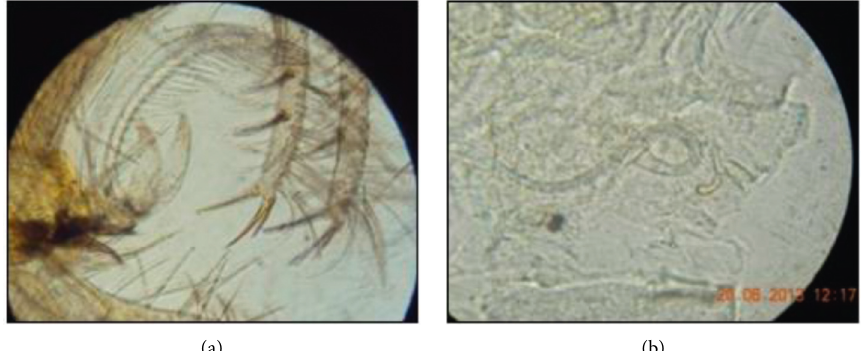
Figure 2: Details of P. papatasi : (a) male penile valves ( G × 40); (b) female spermatheca ( G ×